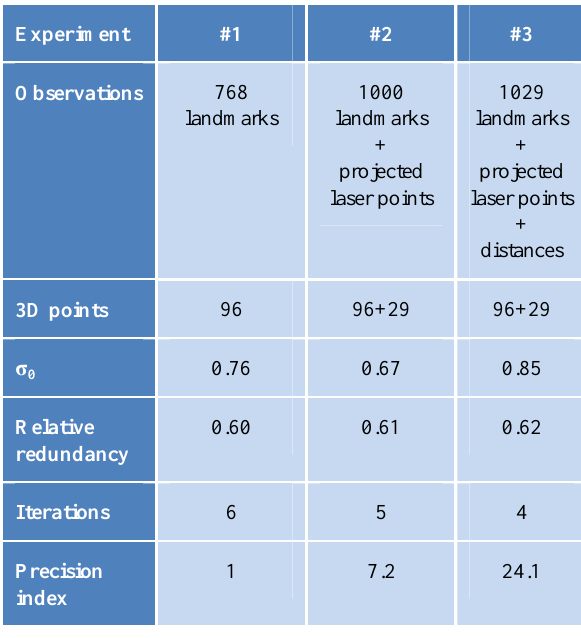
Table 1: Comparison of the adjustment results for three experiments including relative redundancy, estimated factor σ 0 , number of required iterations, and precision index indicating the change in precision for the pose parameter w.r.t. the first experiment.